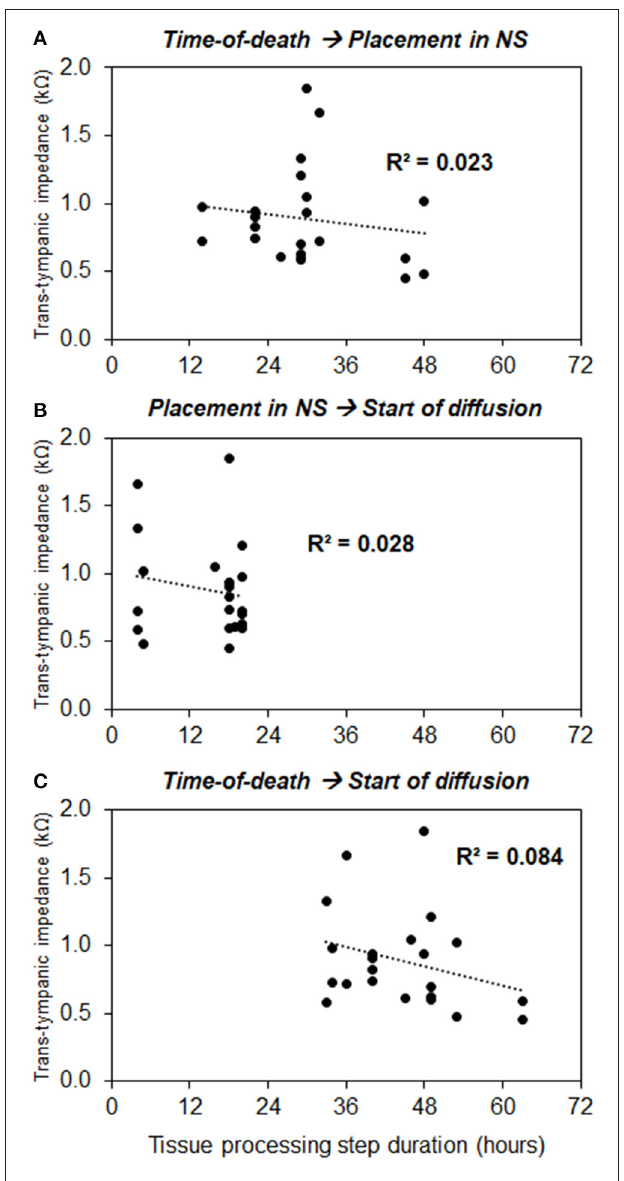
FIGURE 4 | Correlation between processing times and baseline trans-tympanic impedance measurements, with processing time measured as follows: (A) From time-of-death to placement in normal saline, (B) From placement in normal saline to start of diffusion, and (C) From time-of-death to start of diffusion.